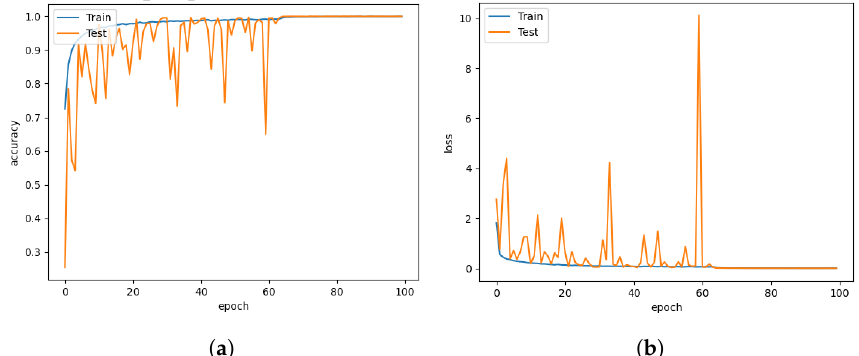
Figure 17. DISubNetV2 for learning rate = 0.001. ( a ) Model accuracy. ( b ) Model loss.